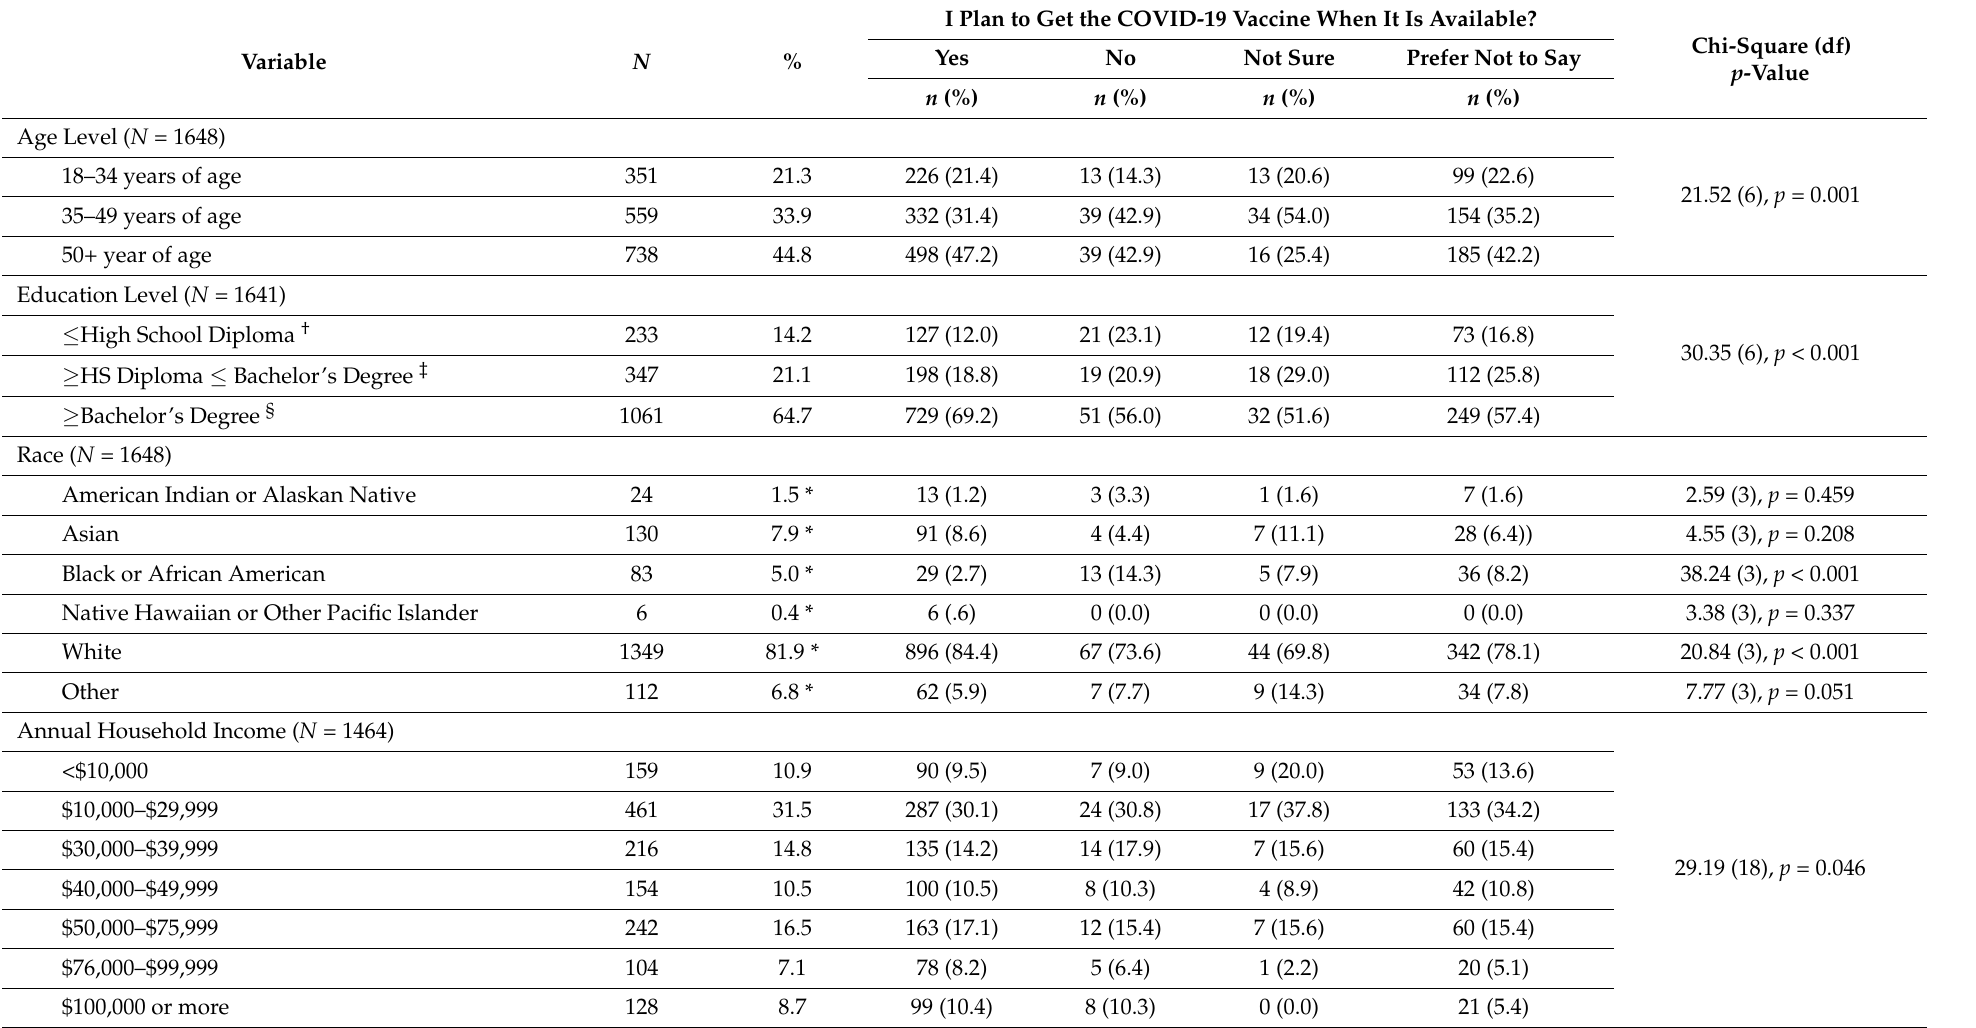
Table 2. Results of chi-square tests of independence of plan to receive the vaccine by selected demographic